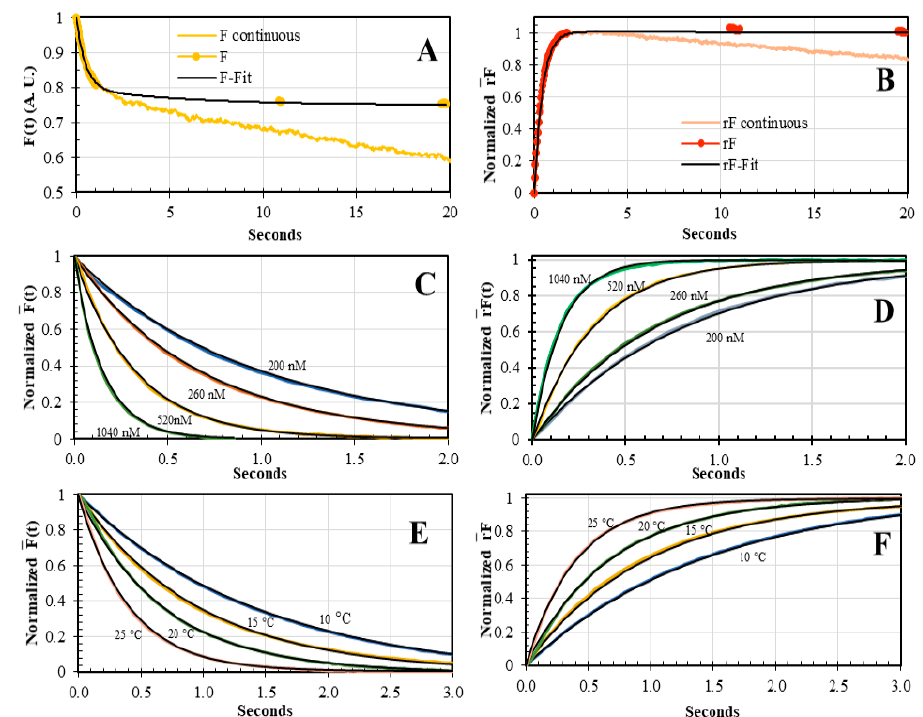
Figure 7. Concentration and temperature dependence of the AV-BcO association kinetics. ( A , B ) The F(t) and rF ( t ) sensing modalities were collected with the dual-channel SF under continuous (pale line) and discontinuous (dotted line) laser excitation at 488 nm. The F(t) trace, under continuous excitation, showed a second eigenvalue ( λ 2 ) that ranged from 0.02 s − 1 to 0.01 s − 1 caused by photobleaching. In contrast, when the excitation was blocked, the intensity stayed constant after the reaction was completed, so that, the intensity decreased by 25.3 ± 2.2% and it was proportional to a change in the QY of 0.91 ± 0.01 for the free BcO probe and the 0.68 ± 0.02 of the AV-BcO complex (Table 2). ( C , D ) The concentration-dependence of the binding reaction of BcO (20 nM) and AV (200 nM, 260 nM, 520 nM and 1040 nM), at 20 ◦ C, for both F ( t ) and rF ( t ) sensing modalities, respectively. ( E , F ) The temperature-dependence in the binding reactions of BcO (20 nM) and AV (260 nM) at 10 ◦ C, 15 ◦ C, 20 ◦ C and 25 ◦ C, were tracked by F ( t ) and rF ( t ) modalities. The black lines corresponded to the fitted curves that yielded the λ and k on values, shown in Table 4.